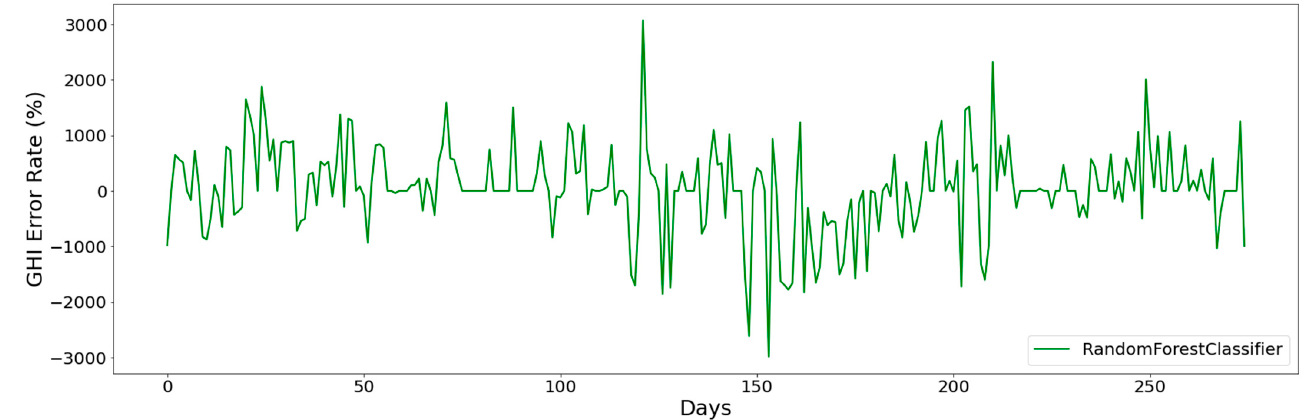
Figure 14. Random forest classifier error frequency rate.